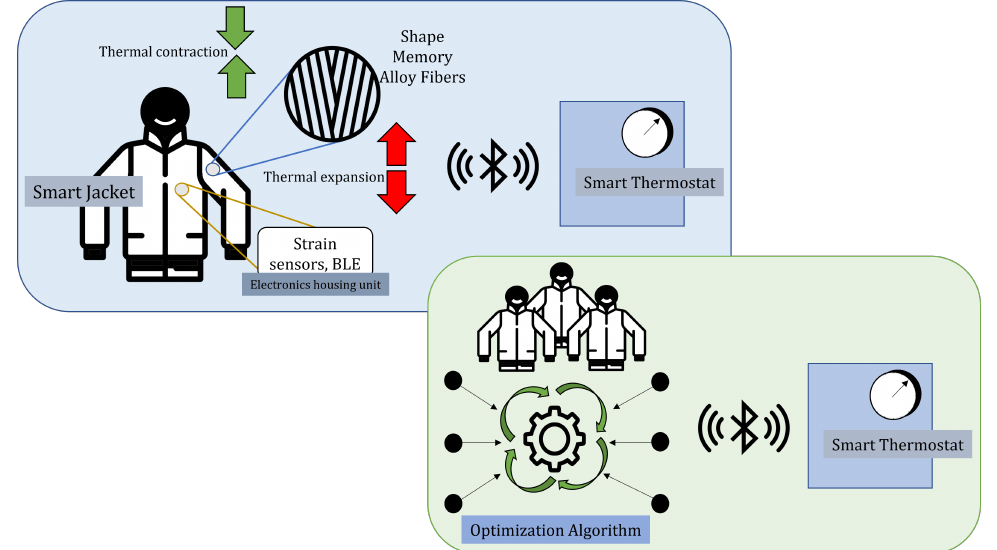
Figure 6. Human-Computer Interaction Use Case: Smart Jacket. Conditions showing single and multi-user states. The change in the length of the SMA fibers woven with the jacket is caused due to phase transformation caused due to a user temperature and environment temperature gradient.